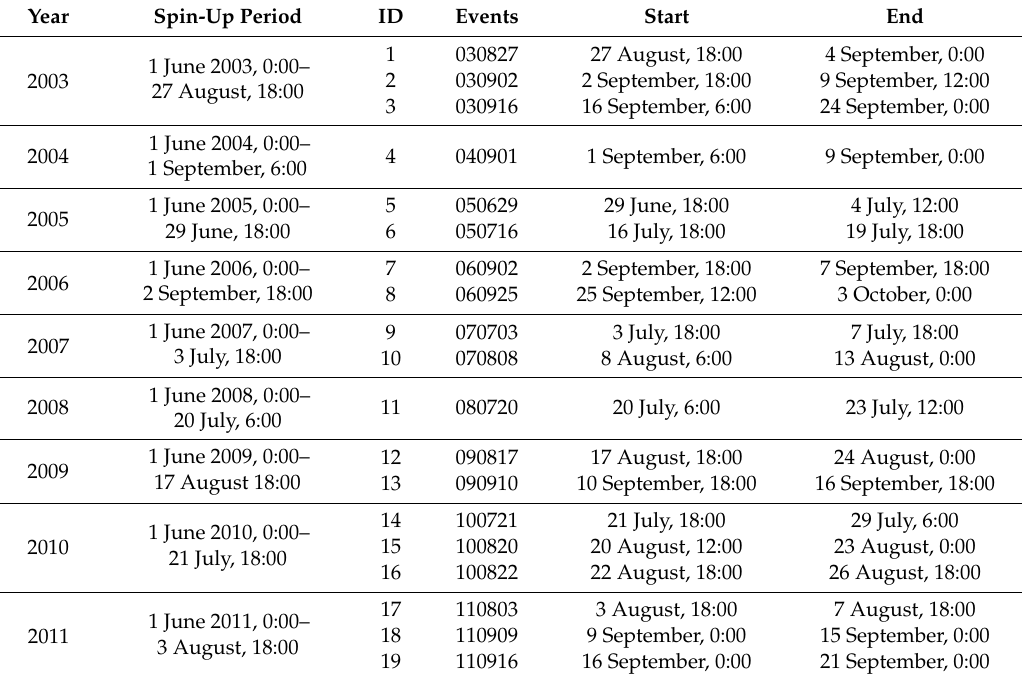
operational global analysis global analysis (FNL) data with the resolution of 0.1 National Center for Environmental Prediction (NCEP) (https: // rda.ucar.edu / ). Table 1. The set of flood events and spin-up period